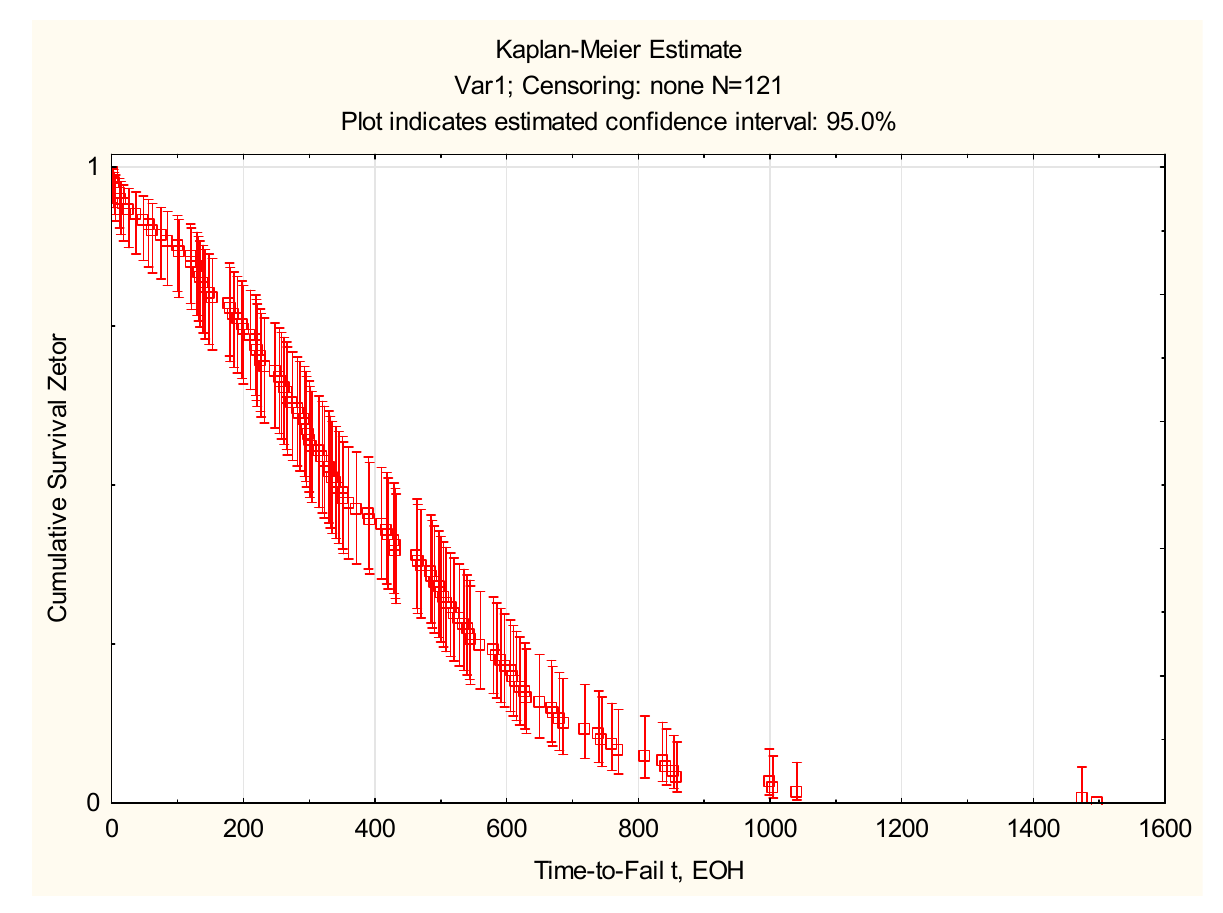
Figure 5. The Kaplan–Meier estimate for Zetor tractors for n = 121 and p = 0.95 (data from Table 1).